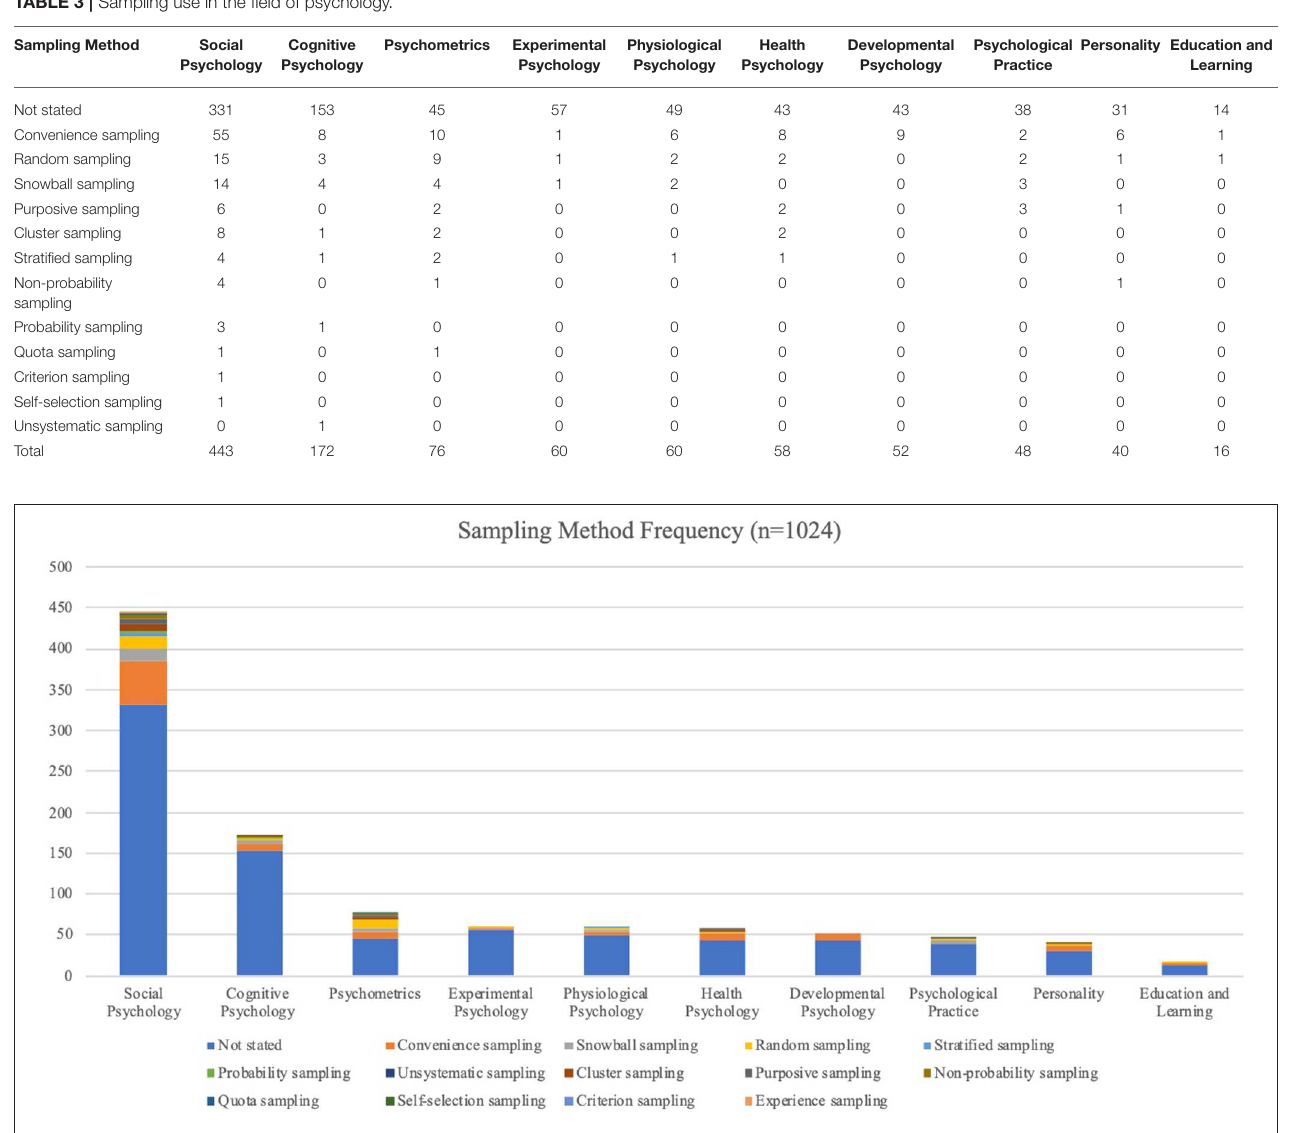
FIGURE 5 | Sampling method frequency in